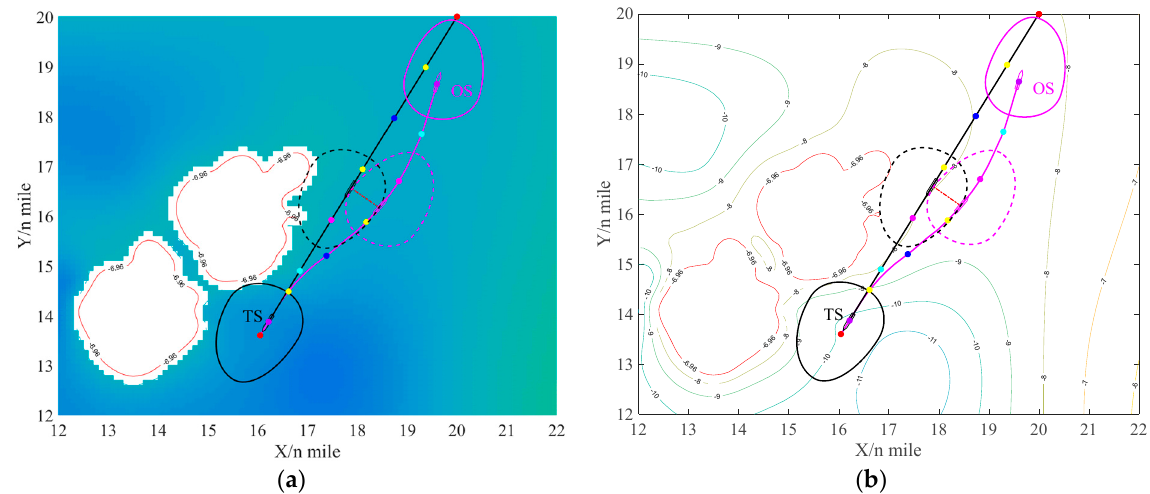
Figure 17. Ship local path planning result in head-on situation. ( a ) Navigable map. ( b ) Depth con- tour.